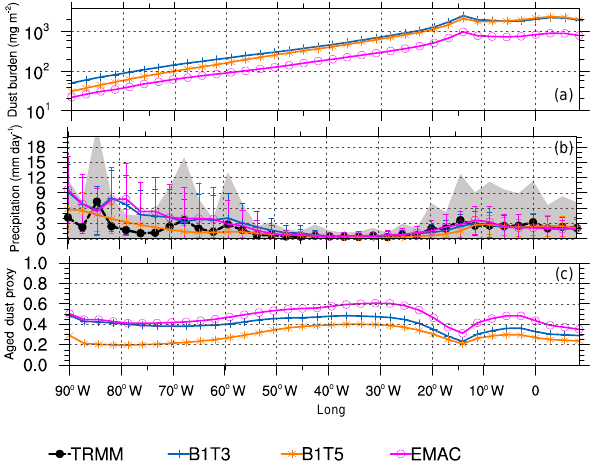
Figure 11. A comparison of the observed and calculated merid- ional means of the dust outflow over the Atlantic Ocean region (10–25 ◦ N) for (top) dust burden, (middle) precipitation and (bot- tom) aged dust proxy (ADP) for July 2009 (monthly mean). The ADP represents the ratio between the aged and non-aged dust parti- cles. The shaded area represents 1 standard deviation of the TRMM precipitation, and the bars show 1 standard deviation of the model